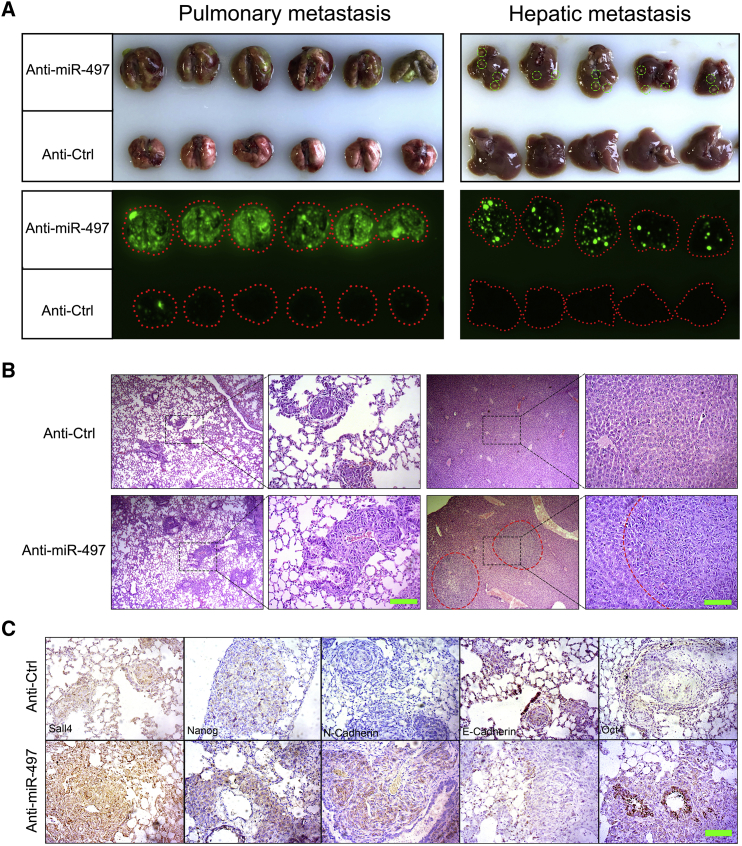
miR-497 Suppressed HCC Metastasis In Vivo(A) Lung and hepatic metastasis of control and anti-miR497 SK-Hep-1 cells in NOD/SCID mice at 6 weeks after tail vein implantation. Lungs and livers from the NOD/SCID mice were dissected, and the presence of HCC metastasis was detected by green fluorescence signal. (B) Representative H&E-stained sections of the lung and liver tissues collected from control and anti-miR-497 groups. Scale bars, 100 μm. (C) Representative IHC staining pictures of the lung sections of control and anti-miR-497 groups. Scale bars, 50 μm.